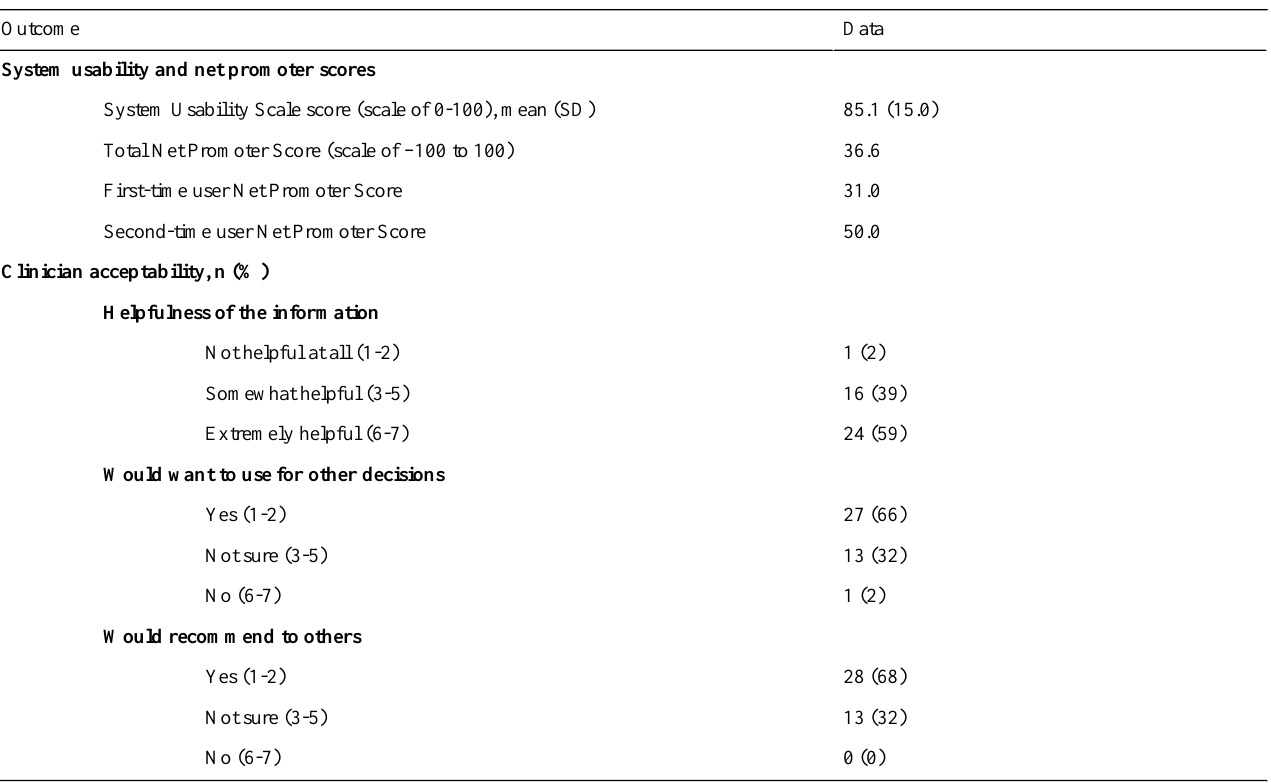
Table 4. Clinician experience outcomes and results.